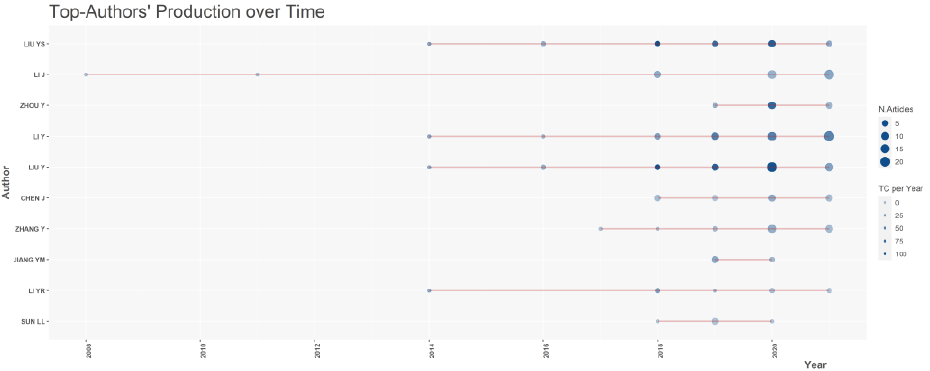
Figure 5. Publication trends of some authors in the field of rural revitalization from 1991 to 2021.